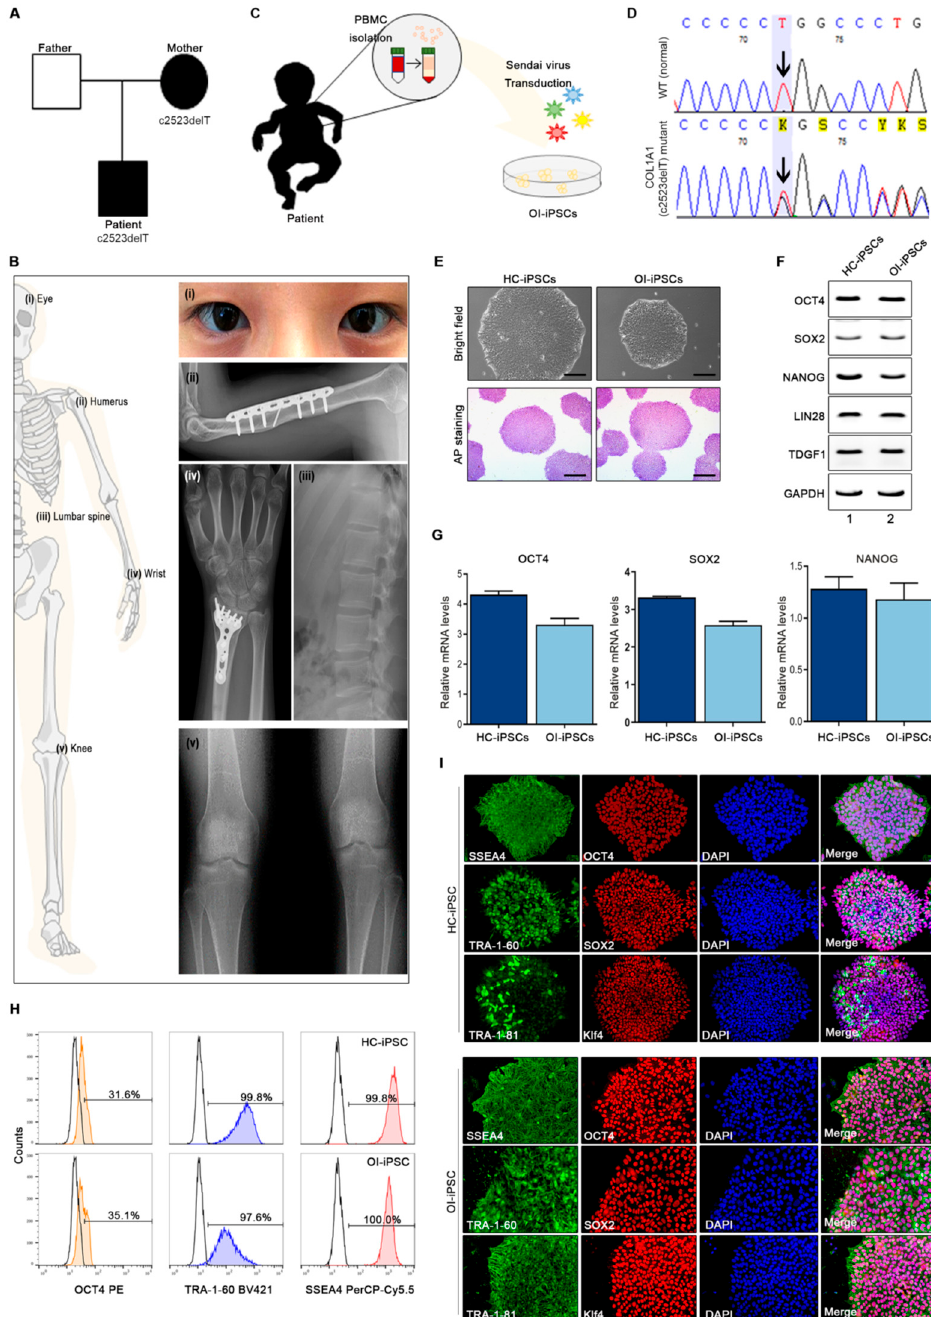
Figure 1. Characterization of iPSCs from healthy control and OI patients. ( A ) Pedigree of the patient and gene sequencing results. ( B ) Clinical phenotypes of OI patients. Transparent blue sclerae caused by abnormal collagen matrix synthesis. Repeated fracture of the humeral shaft. Osteopenic change of carpal bones and repeated fracture of the distal radius. Cortical bone thinning and elevated trabecular bone transparency in the lumbar spines, representing osteopenia. Bone-within-a-bone pattern of vertebral bodies. Thinned cortical bone and reduced bone density. Transverse sclerotic bands in distal femoral and proximal tibial metaphyses. ( C ) PBMCs were isolated from OI patient blood, and iPSCs were generated using Sendai virus. ( D ) Representative DNA sequencing results from OI-iPSCs. ( E ) Morphology of OI and HC-iPSC (upper panel) and alkaline phosphatase (AP) staining (lower panel). ( F , G ) Expression of pluripotency markers in HC-iPSCs ( n = 3) and OI-iPSCs ( n = 3), as determined by RT-PCR and quantitative RT-PCR. GAPDH is a reference gene and was used for quantitative analysis. ( H ) Flow cytometry analysis of cells expressing OCT4, TRA-1-60, and SSEA4. The percentage of OCT4+, TRA-1-60+, and SSEA+ cells in OI and HC-iPSCs. ( I ) Staining for pluripotency transcription factors Oct3/4, Sox2 and KLF4 and cell-surface markers TRA-1-60, TRA-1-81, and SSEA4